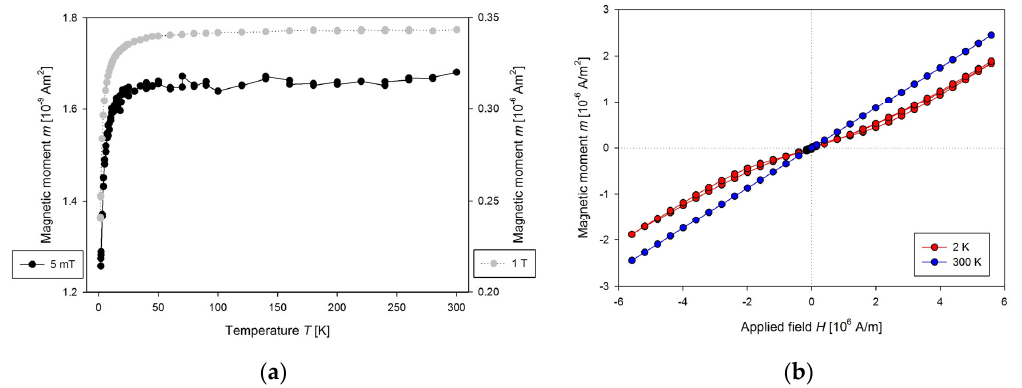
Figure 6. ( a ) The temperature dependence of the magnetic moment for presented plastic sample holder with the cavity filled with He gas measured at 5 mT (left axis) and 1 T (right axis) and ( b ) the magnetic field dependence of the magnetic moment for presented plastic sample holder measured at 2 and 300